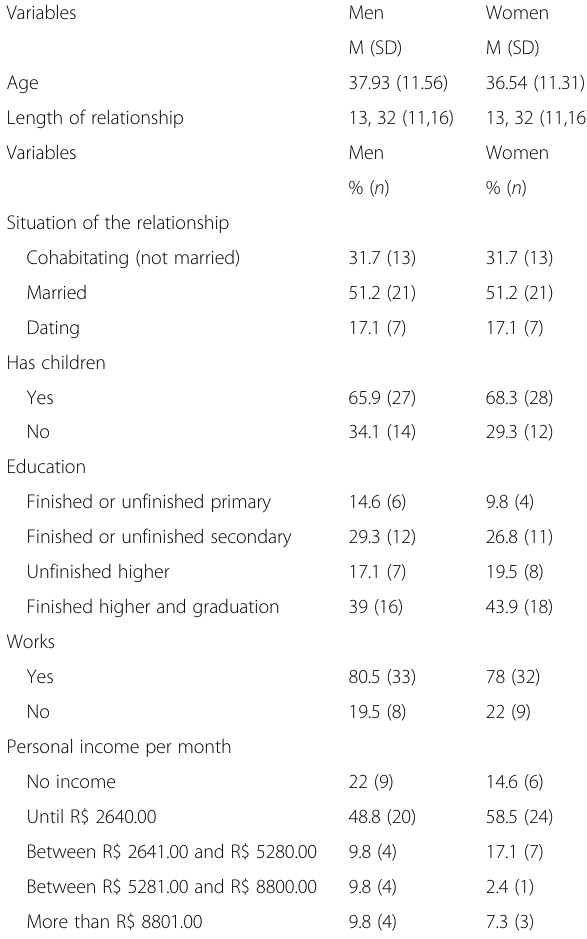
Table 2 Sociodemographic information of participants at